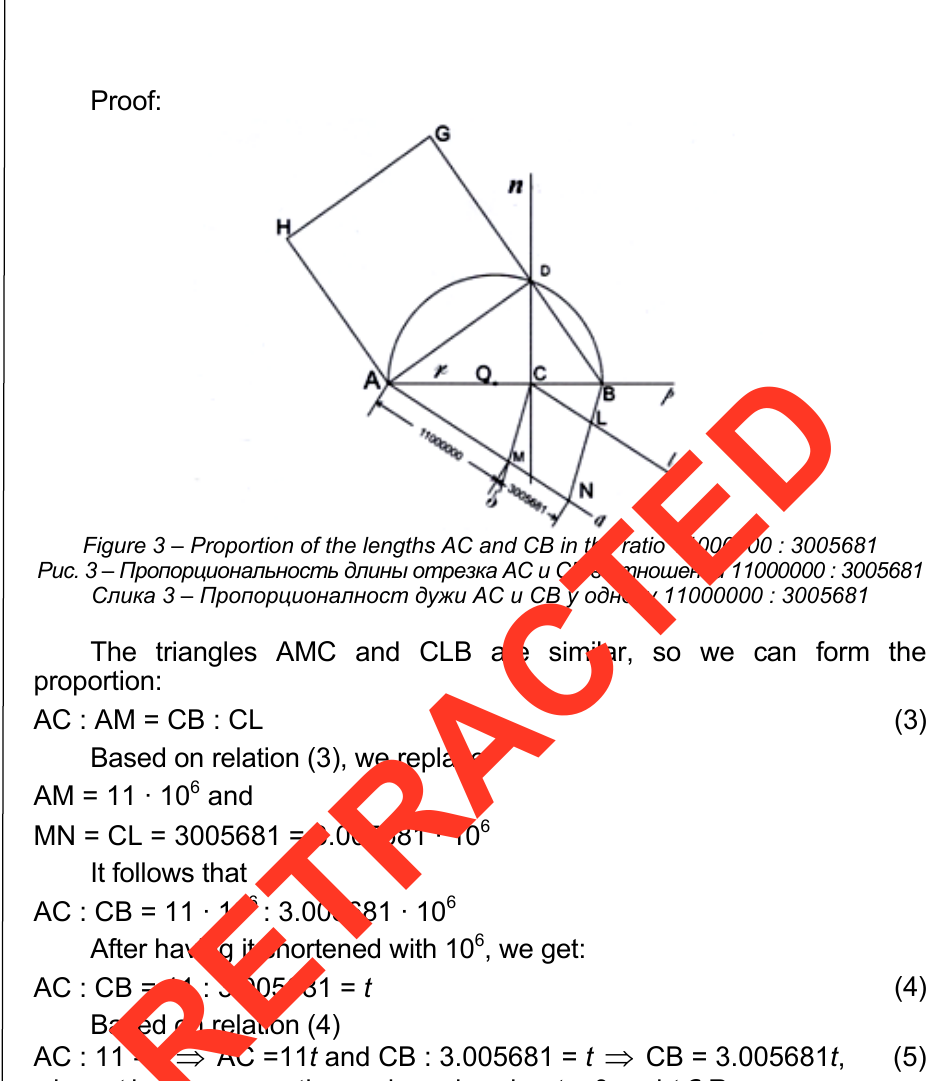
Figure 3 – Proportion of the lengths AC and CB in the ratio 11000000 : 3005681 Рис . 3 – Пропорциональность длины отрезка АС и СВ в отношении 11000000 : 3005681 Слика 3 – Пропорционалност дужи AC и CB у односу 11000000 : 3005681 The triangles AMC and CLB are similar, so we can form the